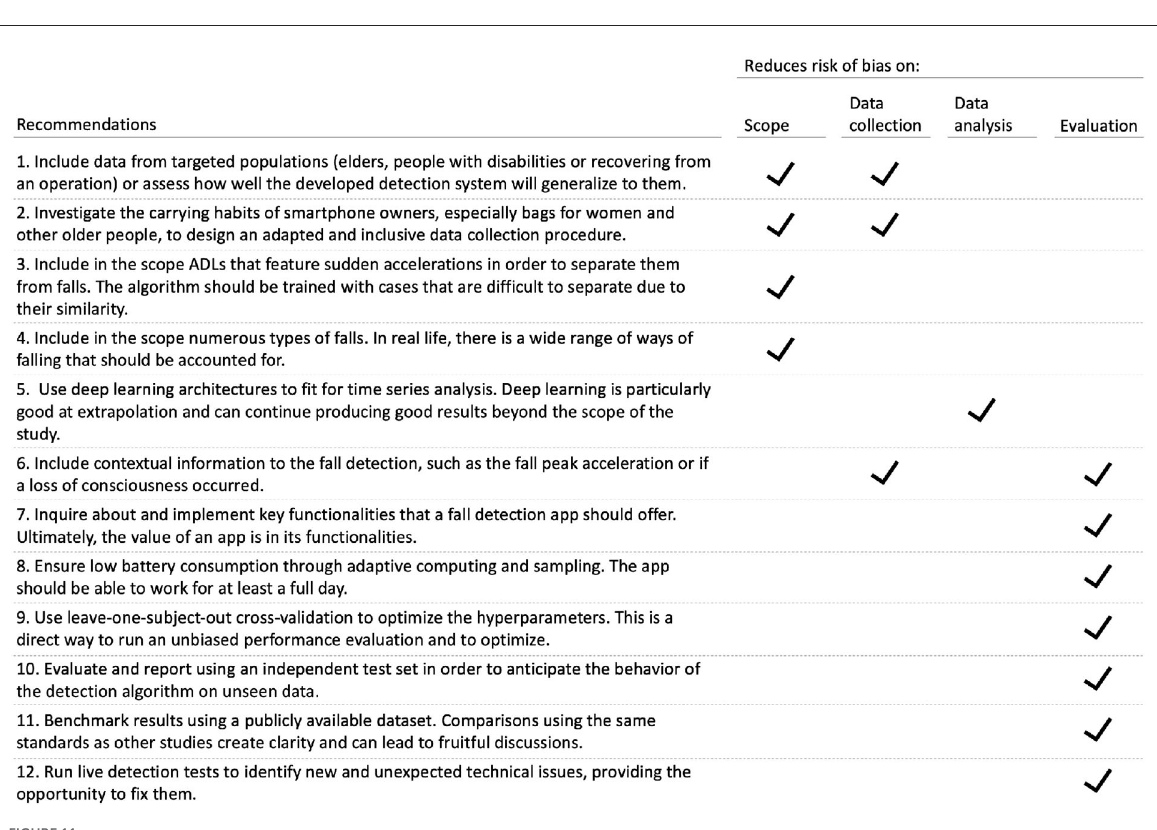
FIGURE11 Twelve recommendations to reduce risk of bias on the scope, data collection, data analysis, and evaluation